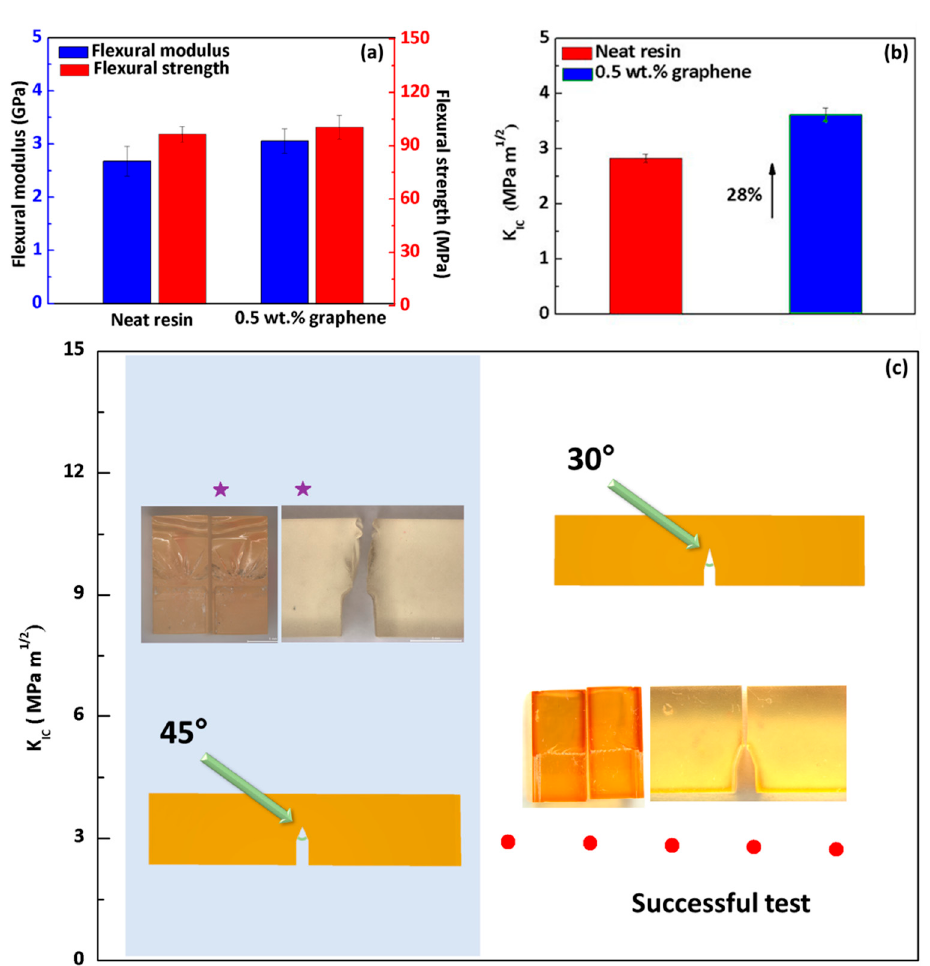
Figure 6. ( a ) Flexural modulus and strength of the neat resin and 0.5 wt.% graphene-reinforced nanocomposites, showing a 14% increase in modulus with addition of graphene. ( b ) Fracture toughness of the neat resin and 0.5 wt.% graphene-reinforced nanocomposites, showing a 28% increase with the addition of graphene nanoplatelets. ( c ) The K IC value and optical images of failed and successful fracture toughness test specimens for the neat resin, with 30 ◦ and 45 ◦ sharp notch tips. Red dot refers to successful test while star refers to failed